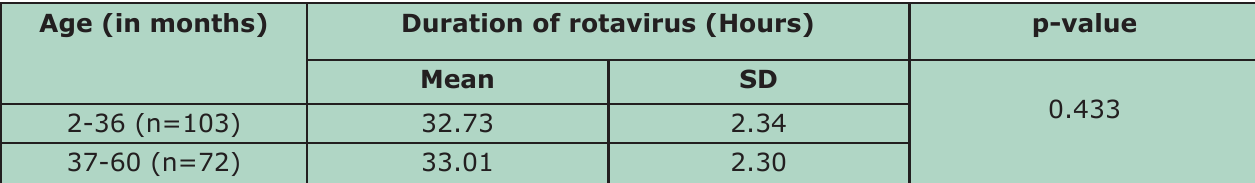
Table-I: Stratification for Mean Duration of Rotavirus Diarrhea in Children After Administration of First Dose of Nitazoxanide with Regards to Age